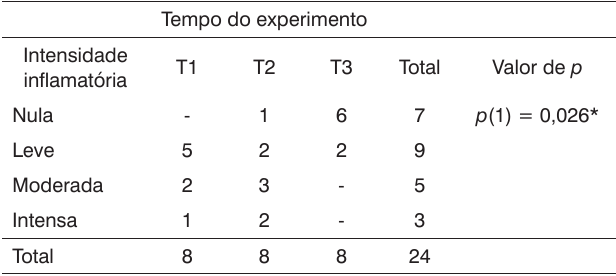
Tabela 3. Avaliação da intensidade do exsudado inflamatório no grupo